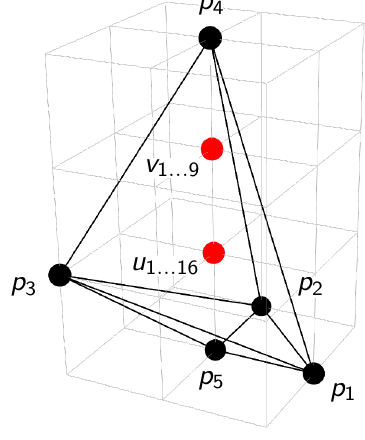
Figure 15 . Toric diagram of Y 3 , 1 ( CP 2 )